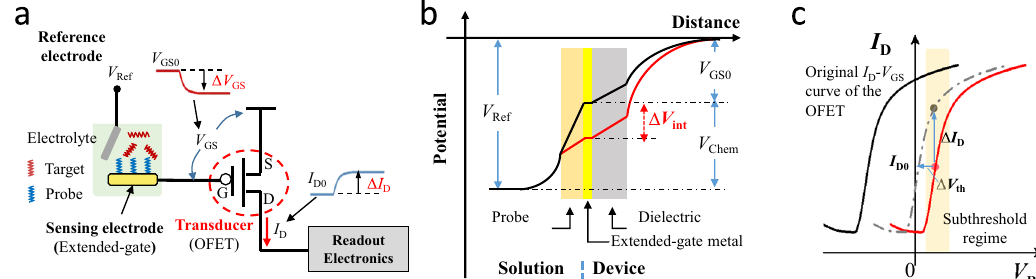
Fig. 1 Illustration of an OFET-based biochemical sensor. a Schematic of the biosensor design for analyte detection in electrolyte solution. The biosensor consists of an OFET transducer and an extended-gate sensing electrode immobilized with probes. V Ref is the bias voltage at the reference electrode (Ag/AgCl). V GS is the resulted gate-to-source voltage on the OFET. I D is the drain current to be measured by the subsequent readout electronic system. b Diagram for potential over a simpli fi ed electrochemical cell model with an extended-gate metal as the interfacial material for sensing. The charged molecules captured onto this surface create a potential shift ( Δ V int ) at the solution/metal interface and thus equal Δ V GS seen from the OFET. c Illustration of the transfer-curve shift from the I D – V GS curve of the OFET to the I D – V Ref curve when the OFET sensor is tested in solution by sweeping V Ref , and the induced signi fi cant output-current change from the background level ( Δ I D0 ) in the subthreshold regime even at a small threshold-voltage shift ( Δ V th concentration. This work demonstrates the feasibility of using the OFET for miRNA sensing. With the optimal device performance, the sensor exhibits a 20% relative output-signal change over the background upon detection of miR-21 (a miRNA biomarker for breast cancer) at 10 pM under an operation voltage less than one volt.